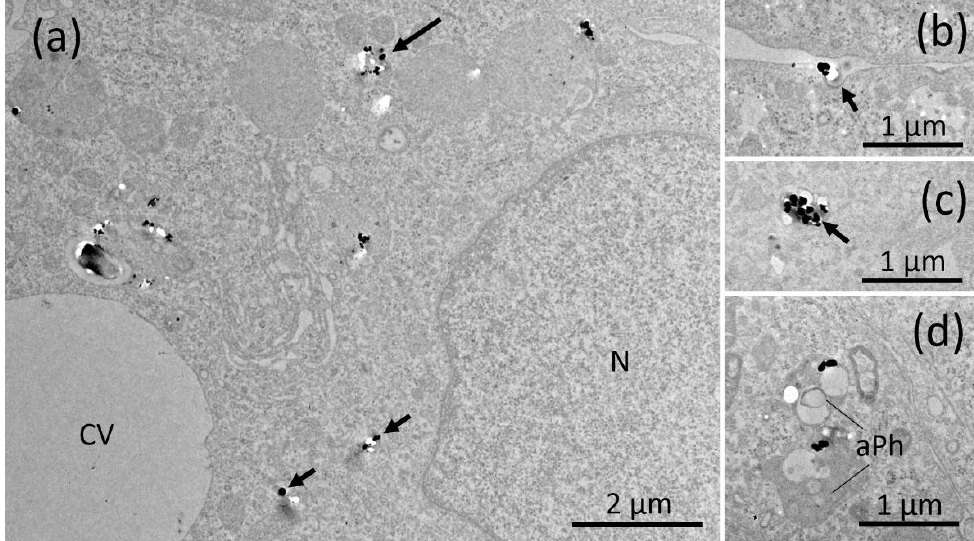
Figure 6. Electron microscopy of NR8383 cells laden with AEROSIL ® OX50 F in the presence of FCS for 16 h. Electron lucent areas close to particles are interpreted as cutting artefacts. ( a ) Overview of a cell with particle-containing phagosomes (large arrows) and smaller endosomes (small arrows). ( b ) A membrane invagination (arrow) underneath a particle attached to the cell membrane, interpreted as an early uptake figure. ( c ) A small particle-filled endosome; ( d ) shows two particle-containing autophagosomes (aPh).